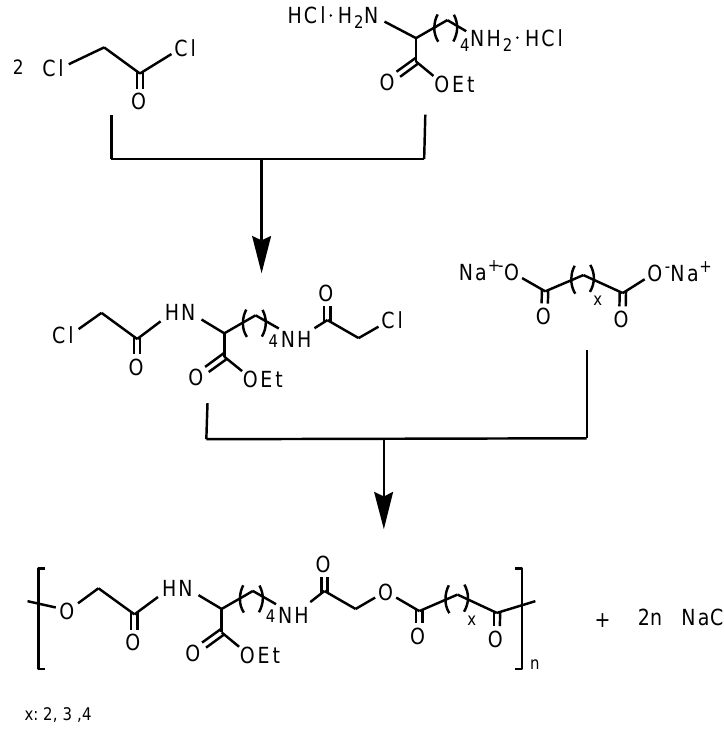
Figure 10. Synthesis of poly(ester amide)s derived from glycolic acid and L-lysine ethyl ester by a thermal polycondensation reaction induced by the formation of metal halide